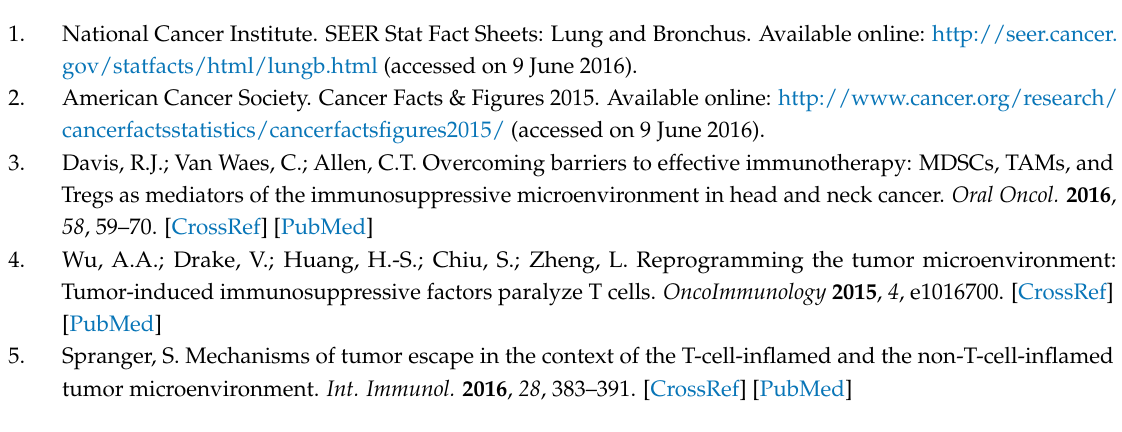
Figure S1: 344P and 393P response to anti-PD-1 treatment in vivo, Figure S2: Ntrk1 shRNA does not demonstrate significant dropout from 393P tumors treated with anti-PD-1 antibody, Figure S3: Cell lines derived from anti-PD-1 resistant tumors maintain resistance when re-challenged with anti-PD-1 antibody in vivo, Figure S4: Ntrk1 expression correlates with the mesenchymal status of cells, Figure S5: Overexpression of Ntrk3 increases cell migration, invasion, 3D growth, and signaling via MAPK and AKT pathways, Figure S6: Ntrk1 promotes cellular growth through MAPK signaling, Figure S7: T cell proliferative capacity is inhibited as a function of Ntrk1 expression through PD-L1 activity, Figure S8: Treatment with a Jak1/2 inhibitor blocks upregulation of Irf1 and PD-L1 in splenocyte co-culture, Table S1: Positive and negative controls for FDAome dropout screen, Table S2: RSA values and rank scores for the FDAome shRNA dropout screen with a PD-1 blocking